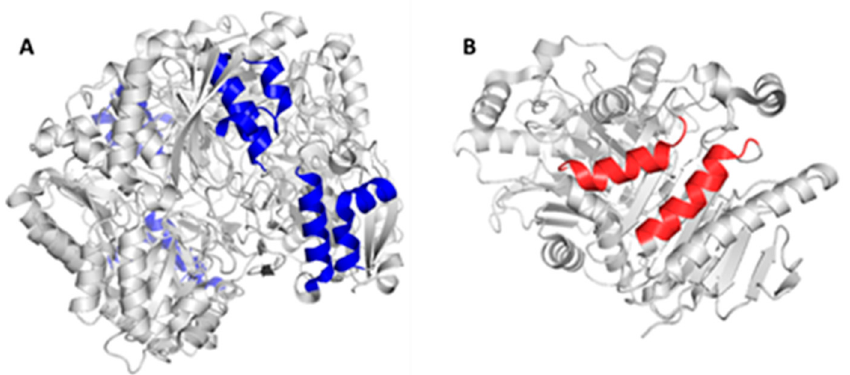
Figure 2. Substituted sequences for the construction of the chimeric E. coli L-asparaginase enzyme. ( A ) Tetrameric structure of L-asparaginase II from E. coli 3ECA; the residues to be substituted by peptide fragments of the human enzyme are indicated in blue. ( B ) Dimeric structure of human L-asparaginase (4O0H); the fragments of the human enzyme that align to the bacterial enzyme and that were used as substituents in the formation of the chimeric construct are indicated in red. Both fragments have the same secondary structure.